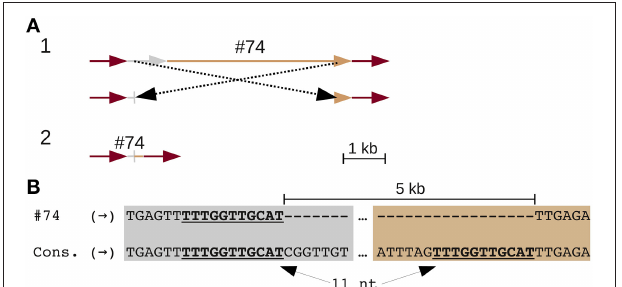
FIGURE 2 | An internal CR deletion by homology-mediated recombination. CR2 element (#74 in Table S5) has identical LTRs, which date the insertion and subsequent recombination of this element to < 16.4 kya. (A) Line drawing illustrates (part 1) recombination between UTR (gray) and CDS (tan) leading to the observed truncated CR identified in CEN10 (part 2). The CR2 LTRs are colored red. (B) Alignment of the UTR and CDS deletion junction to consensus CR2 sequences illustrates that the deletion is mediated by 11 nt of identical sequence